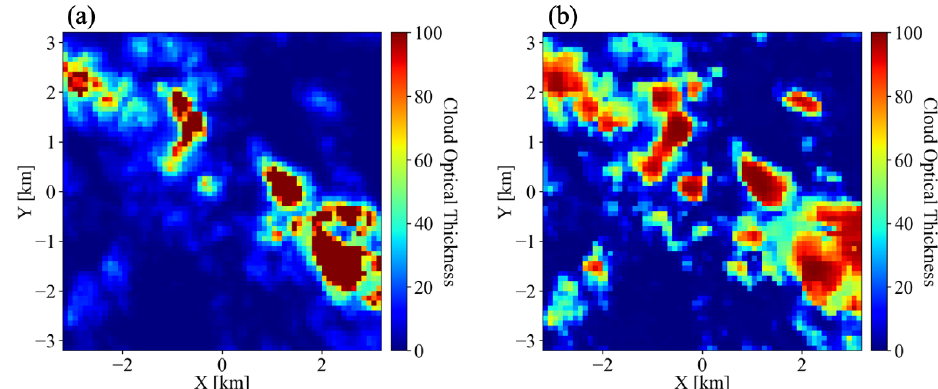
Figure 11. Cloud optical thickness for the gridded radiance in Fig. 10b (a) estimated by IPA method and (b) predicted by CNN.